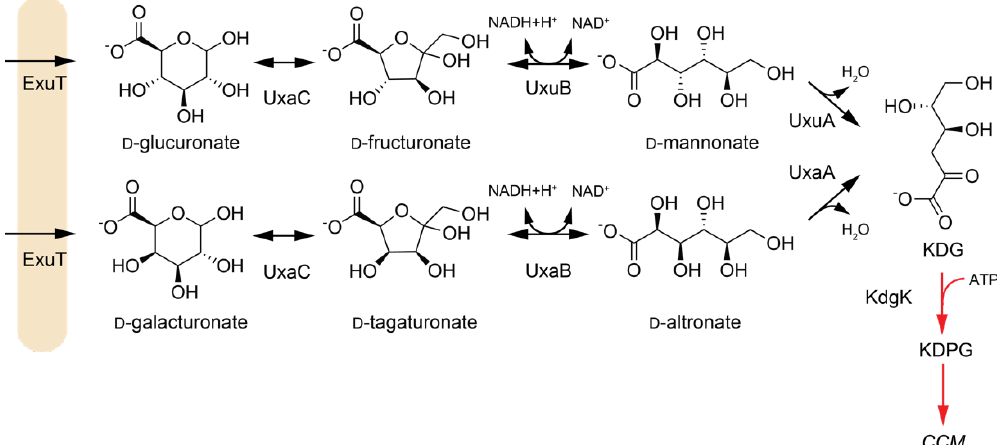
Figure 1. Metabolism of hexuronates in E. coli. Red arrows indicate analogous route to the Entner – Doudoroff (ED) pathway. ExuT: Hexuronate transporter, UxaC: Hexuronate isomerase, UxuB: Mannonate oxidoreductase, UxaB: Altronate oxidoreductase, UxuA: Mannonate dehydratase, UxaA: Altronate dehydratase, KdgK: 2-Keto-3-deoxygluconate kinase, KDG: 2-Keto-3-deoxygluconate, KDPG: 2-Keto-3-deoxy-6-phosphogluconate, CCM: Central carbon metabolism. Adapted from [47].